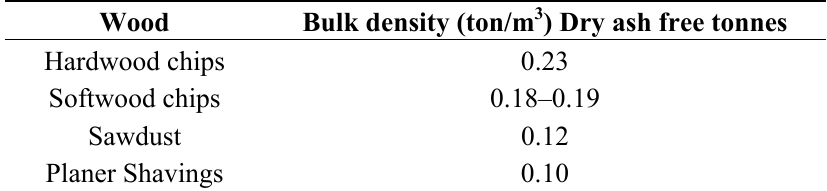
Table 2. Bulk densities of different types of wood [15].